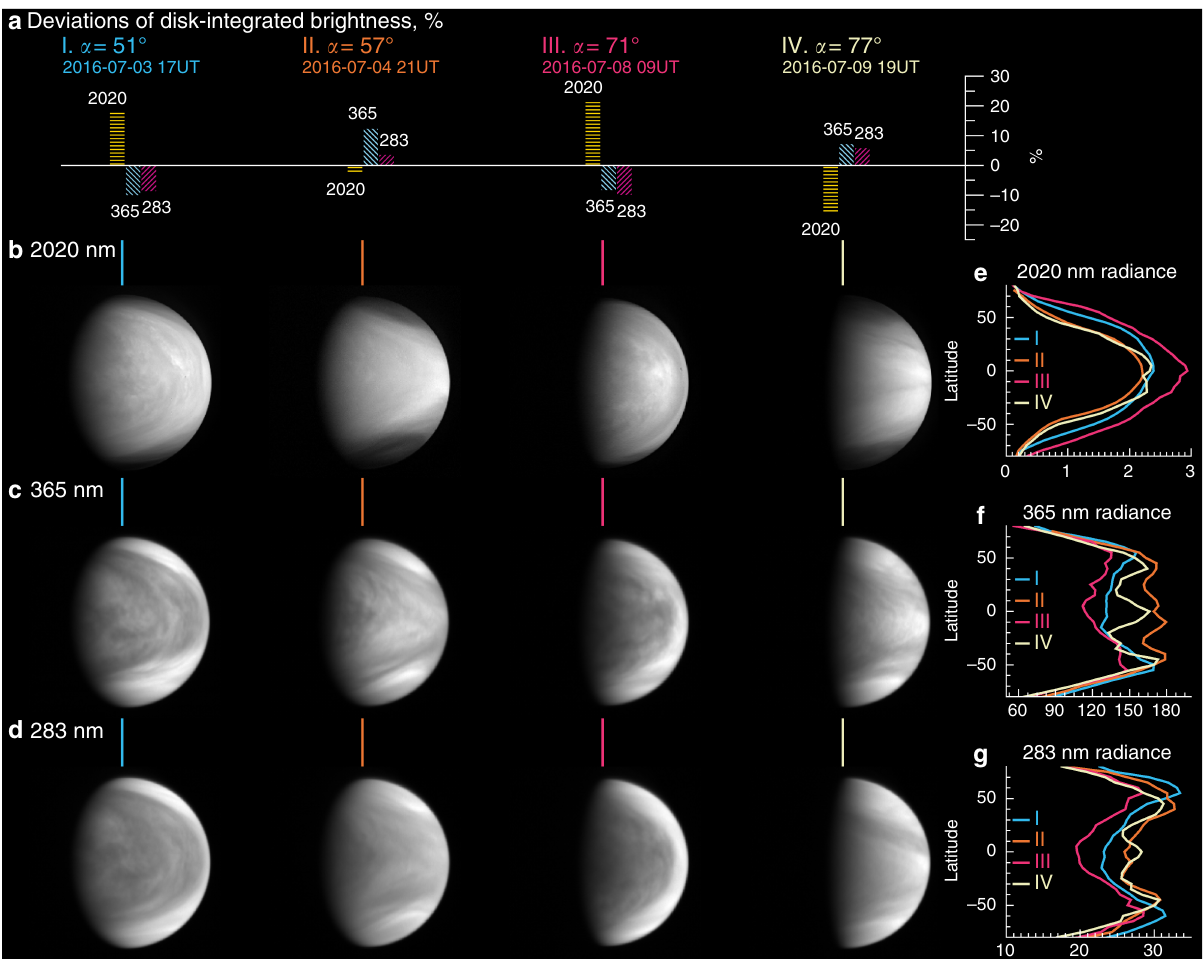
Fig. 2 Variable cloud morphology during orbit 20 (2 – 10 July 2016). a Deviation of disk-integrated brightness, %, from the mean phase curve (Fig. 1a). b Venus disk and brightness distributions at 2020 nm. All images show north at the top, white for high radiance, and black for zero radiance, and mostly the afternoon sides are visible. c Same but at 365 nm. d Same but at 283 nm. Roman numerals (I – IV) in a and vertical lines in ( b – d ) indicate three- wavelength images at speci fi c solar phase angles ( ∘ ) and times (YYYY-MM-DD HH in UTC). e 2020 nm latitudinal mean radiance [W m − 2 str − 1 μ m − 1 ] at I – IV. f 365 nm latitudinal mean radiance at I – IV. g 283 nm latitudinal mean radiance at I –